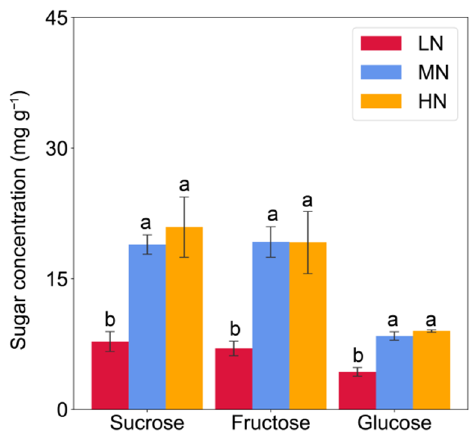
Figure 2. Sugar concentrations in the leaf (the 8th fully expanded) of maize plants under low, medium, and high nitrogen supply at 62 days after sowing. Vertical bars indicate the standard error of the mean ( n = 4). Different letters above the columns represent significant differences within each sugar between nitrogen treatments ( p < 0.05). LN, no nitrogen application; MN, 0.15 g N kg − 1 ; HN, 0.30 g N kg − 1 .